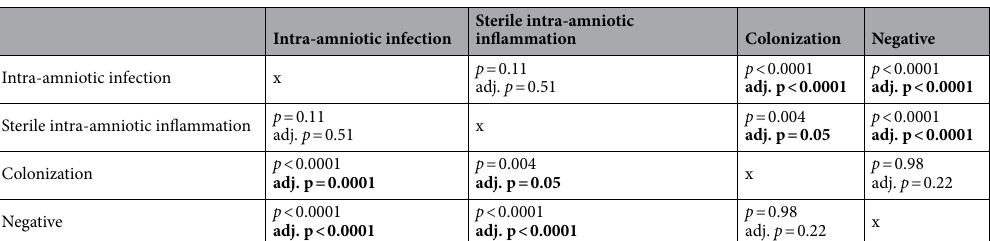
Table 4. IgGFc-binding protein in amniotic fluid from preterm prelabor rupture of membranes: the comparisons among the subgroups of the women with intra-amniotic infection, sterile intra-amniotic inflammation, colonization, and negative amniotic fluid. p -value: a comparison between two subgroups (a nonparametric Mann–Whitney U test); Adj. p -value: a comparison between two subgroups after the adjustment for gestational age at sampling (a Spearman partial correlation). Statistically significant results are marked in bold.